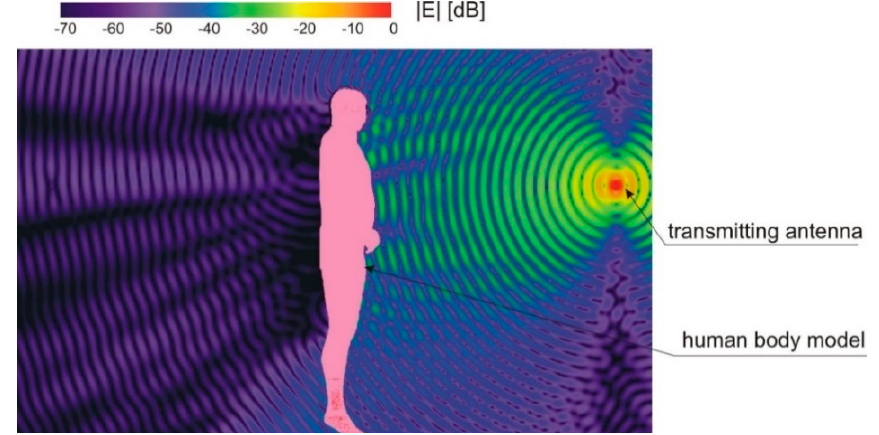
Figure 3. Electric field intensity in proximity to a human body simulated in XFdtd.